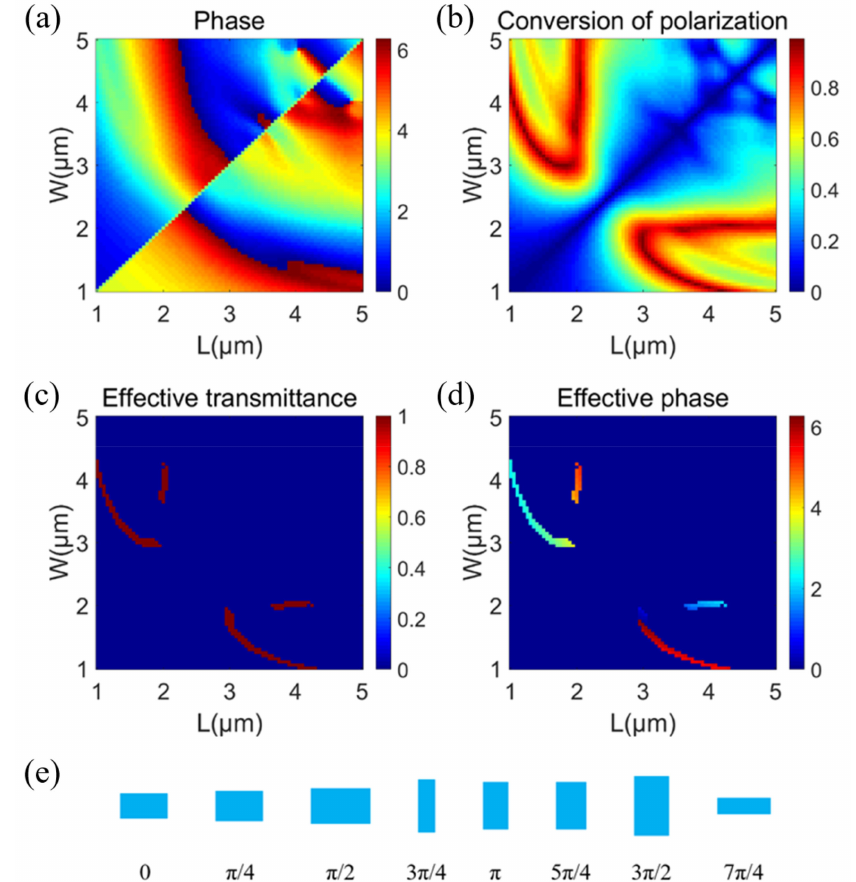
Figure 5. ( a ) The relationship between the propagation phase and the length and width of the nanorods when the LCP light is the main transmitted light. ( b ) The conversion rate of polarization when the RCP light is incident. ( c , d ) The transmission and propagation phase distribution of the unit cells meeting the conditions of transmittance > 0.9 and conversion rate > 0.9. ( e ) Schematic of the 8 basic unit cell